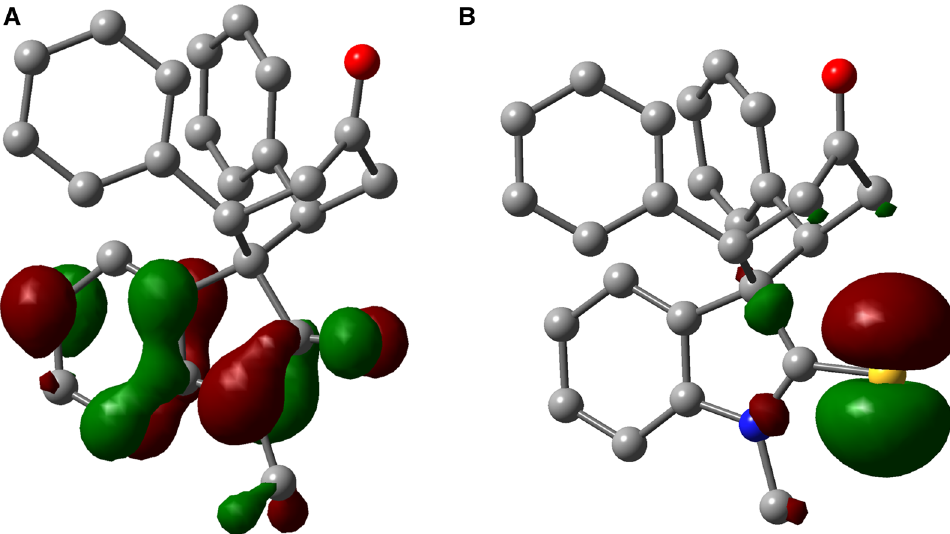
Figure 4. HOMO electronic cloud of ( A ) cis -spirooxindole 2 and ( B ) cis -spirothiooxindole 4 . The diffusive electronic cloud around the sulfur atom in thiooxindole makes the cis isomer to be more stable than the trans isomer. DFT calculations were performed using B3LYP/6-31 + G(d) in the gas phase. The figure was drawn using GaussView version 6.1.1 (https:// gauss ian. com/ gauss view6) 40 .